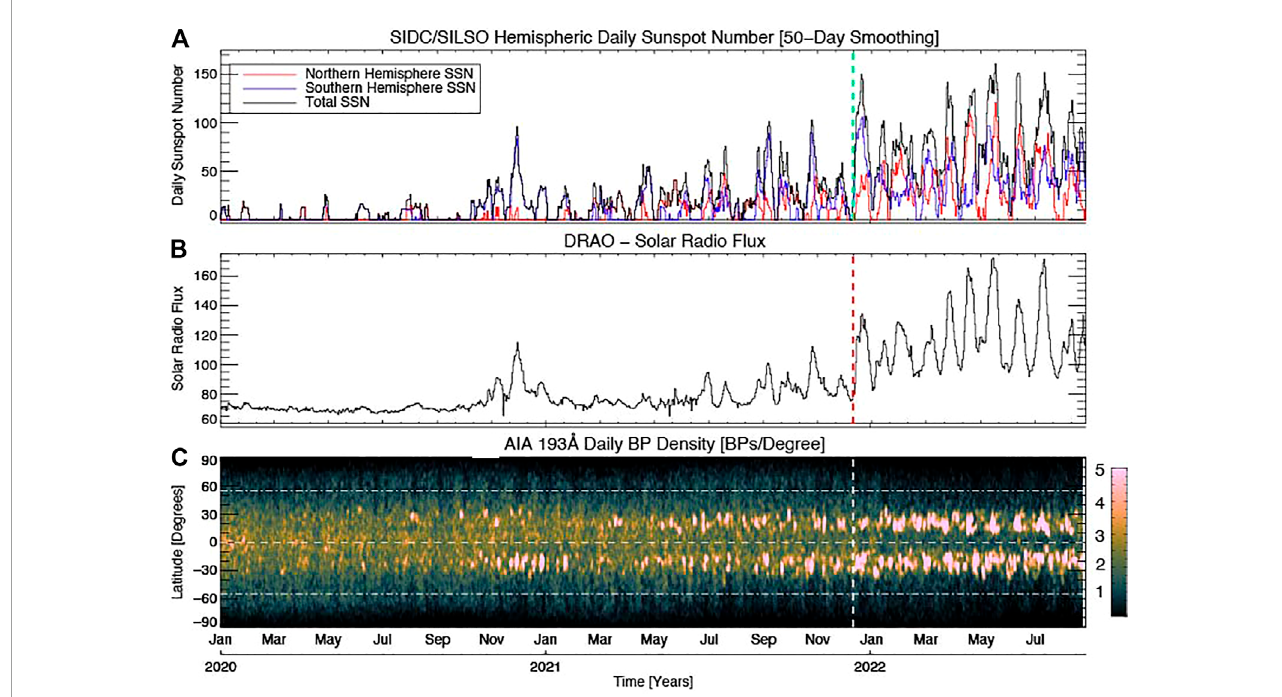
FIGURE 9 Contrasting fluctuations in the daily, central-meridian, latitudinal distribution of BP density versus some proxies of solar activity into the early phases of SC25. From bottom to top we compare the daily BP variation at equatorial and activity belt latitudes (Panel C - Figure 2C ), the 10.7 cm DRAO solar radio flux (Panel B - Figure 6D ), and the SDIC/SILSO hemispheric sunspot number (red - northern hemisphere and blue - southern hemisphere).